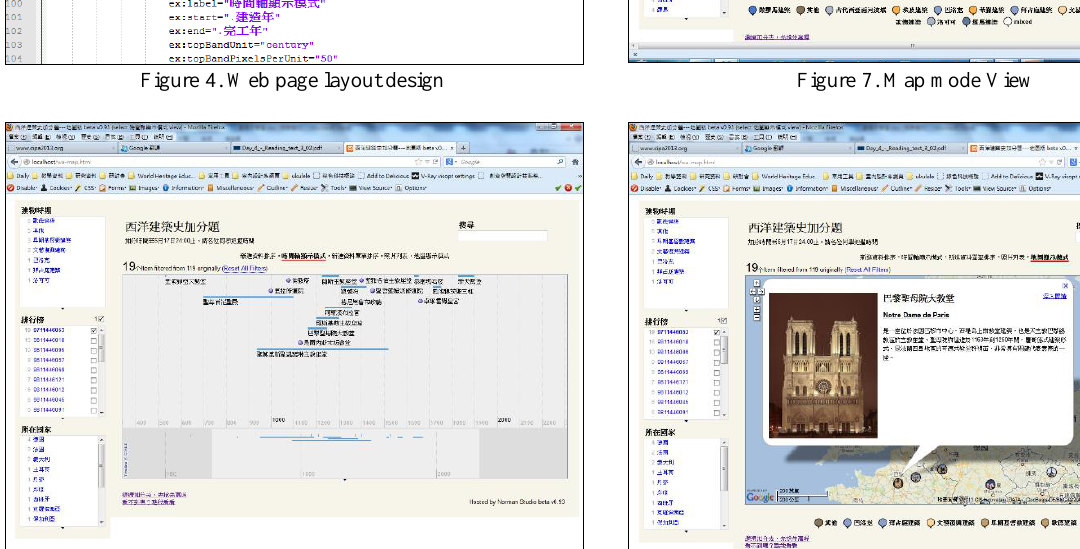
Figure 5. Timeline mode view